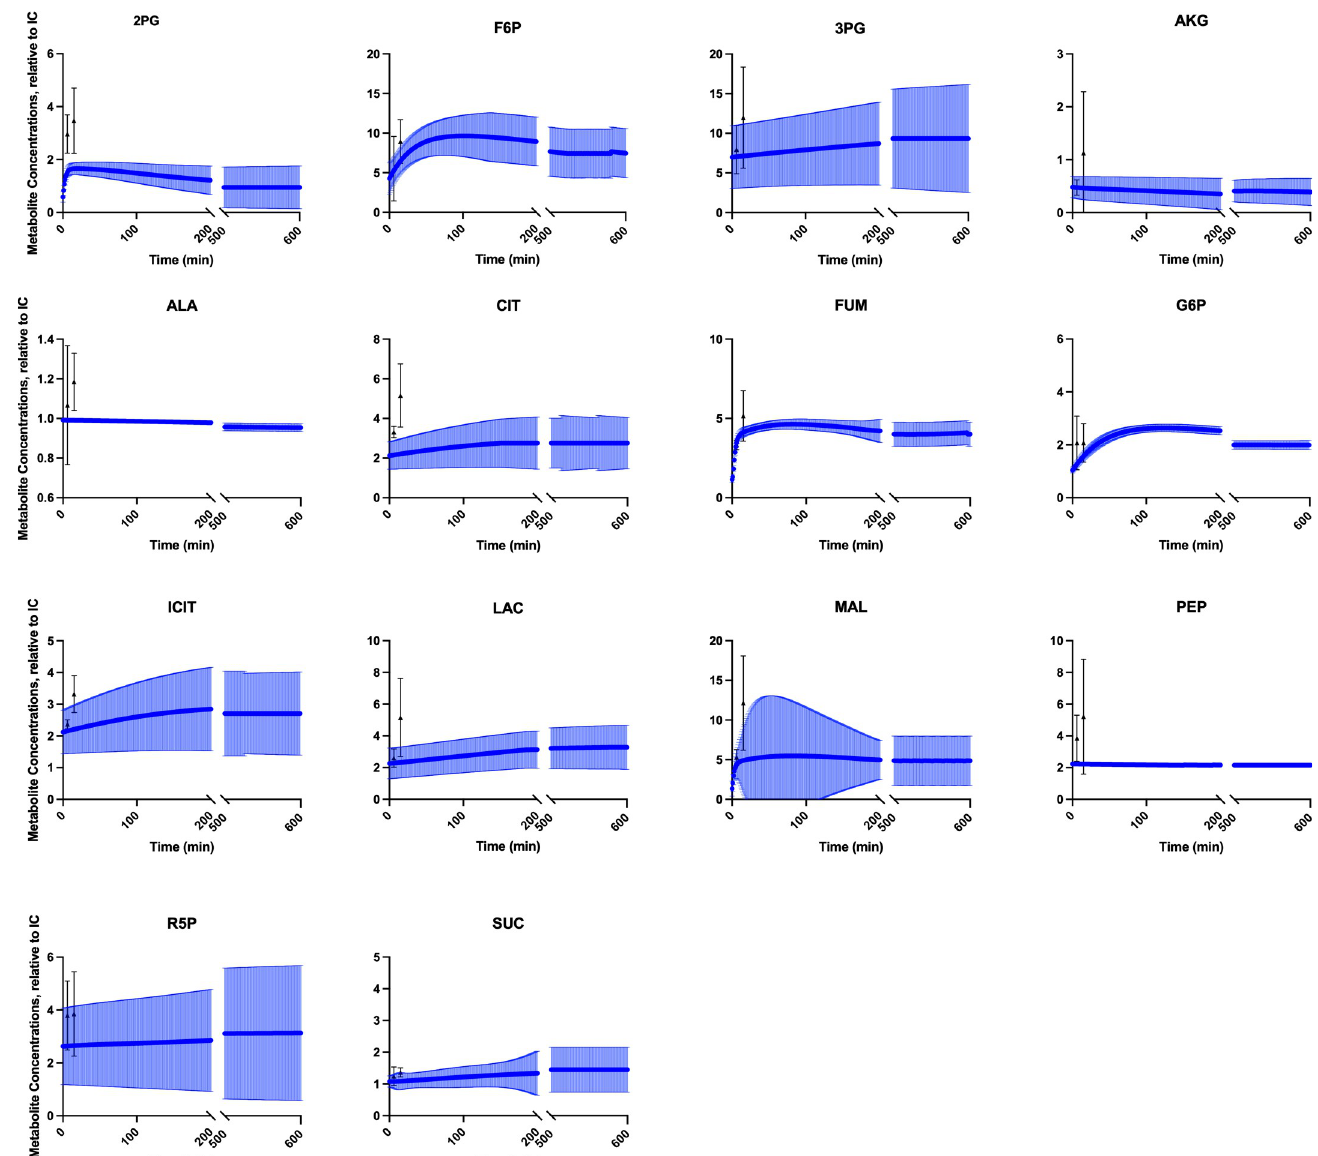
Fig 3. Model fit to experimental data relative to initial state. We trained the model to mass spectrometry data published by Spegel et al. for 14 metabolites (at 16.7mM glucose), relative to the initial 0-minute condition[52]. The experimental data (black triangles for measurement average, bars representing data standard deviation) are at the 6- and 15-minute timepoints. The model simulations (blue dots for average prediction, blue bars showing standard deviation) demonstrate that the model reaches a steady state condition, within 200 minutes for most metabolites. Predicted timecourses for all metabolites predicted by the model are shown in Fig D in S1 Supporting Information